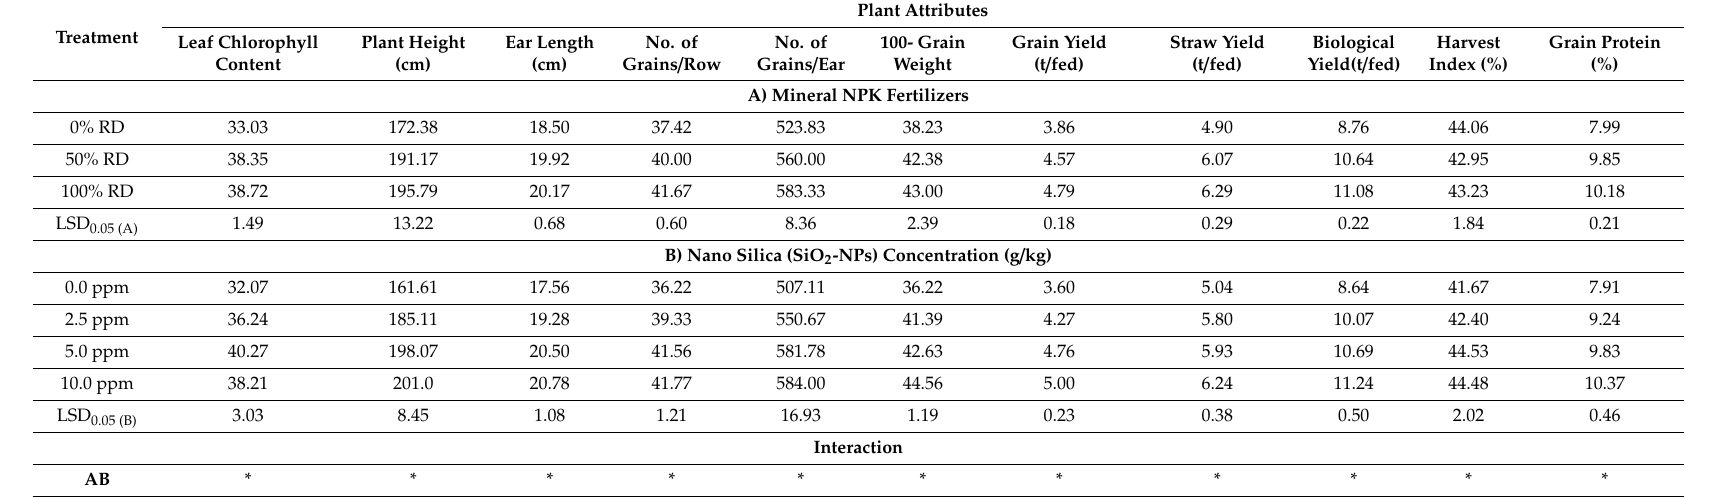
Table 2. Plant attributes of maize as a ff ected by mineral NPK fertilizers, Nano silica (SiO 2 -NPs) concentrations and their interaction in an average of the two seasons 2018 and